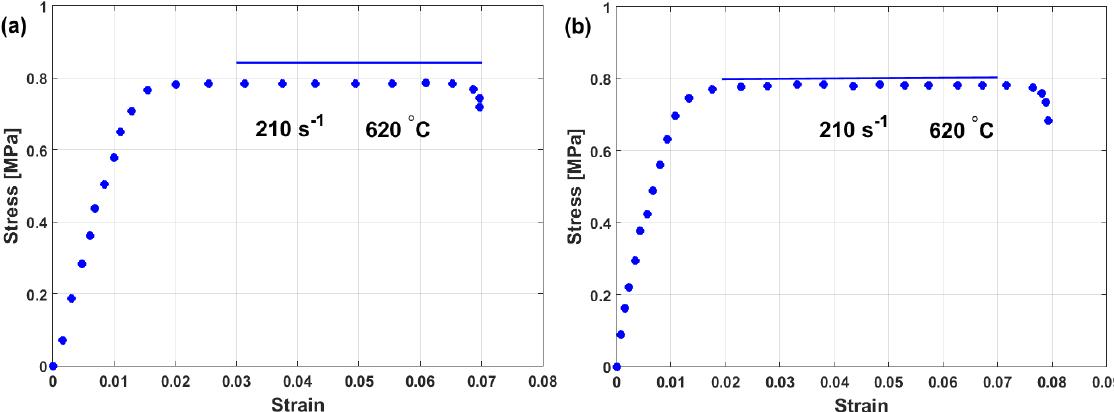
Figure 27. Experimental stresses (markers) compared to predicted stresses (solid lines) of titanium matrix composite under hot deformation using ( a ) the original JC and ( b ) the modified JC that was presented by Song et al. [81].